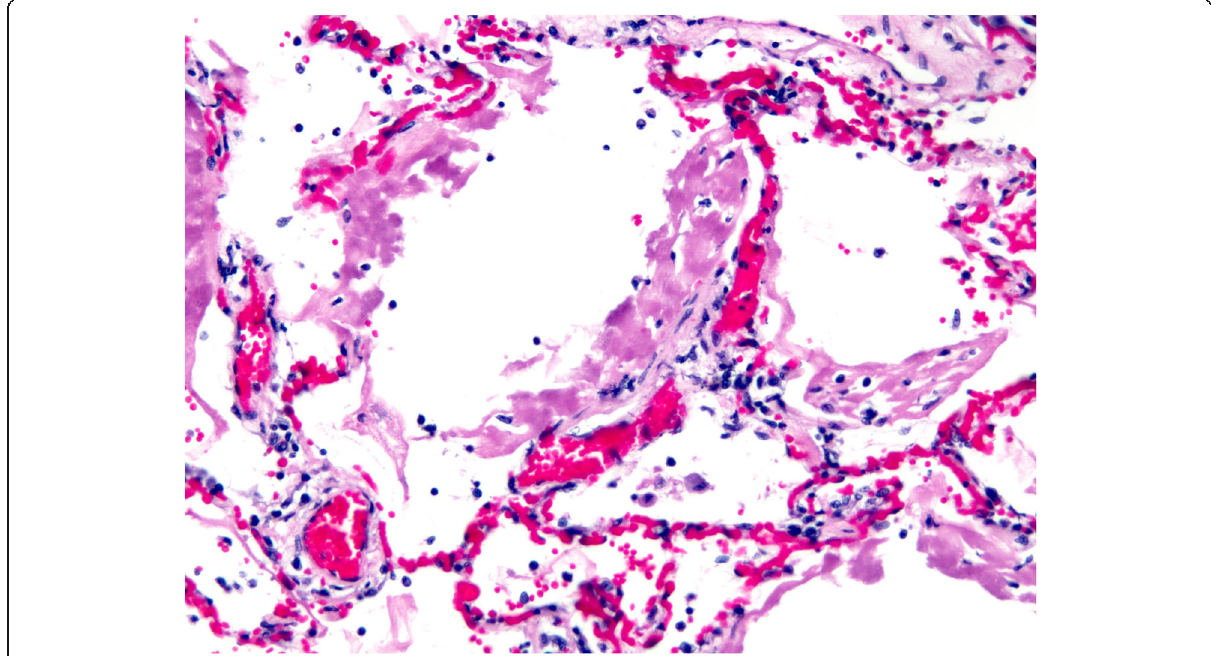
Fig. 5 Diffuse alveolar damage in COVID-19. Note prominent hyaline membranes. (Hematoxylin & eosin, original magnification × 200). There is no evidence of “ diffuse microthrombi ”